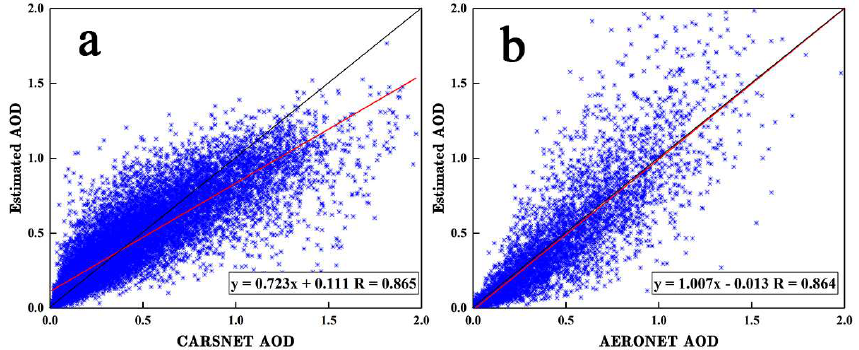
Figure 6. Validations of the estimated AOD by the Genetic_BP at the CARSNET and AERONET stations during 2002–2014 ( a for CARSNET stations, b for AERONET stations).